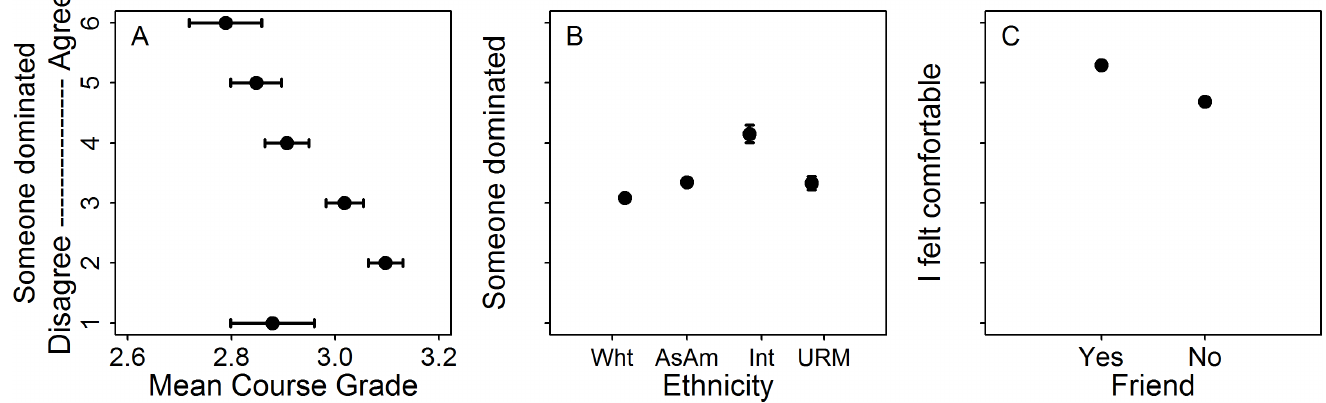
Fig 2. Raw means show that some student characteristics predict which students report a dominator and being comfortable in their group. A) Students who have low course grades report higherlevels of a dominator; B) International students (Int) and Asian-American students (AsAm) report higherlevels of a dominator than white students (Wht), and there is no difference in dominator report rate betweenwhite students and URM students; C) The single predictor determininga student’s comfort in their group was whether(or not) they worked with a friend. Error bars indicatestandard error and are present on all plots, despite being very small and subsumedby points in some cases. See Table 2 for final models and modeledestimates.